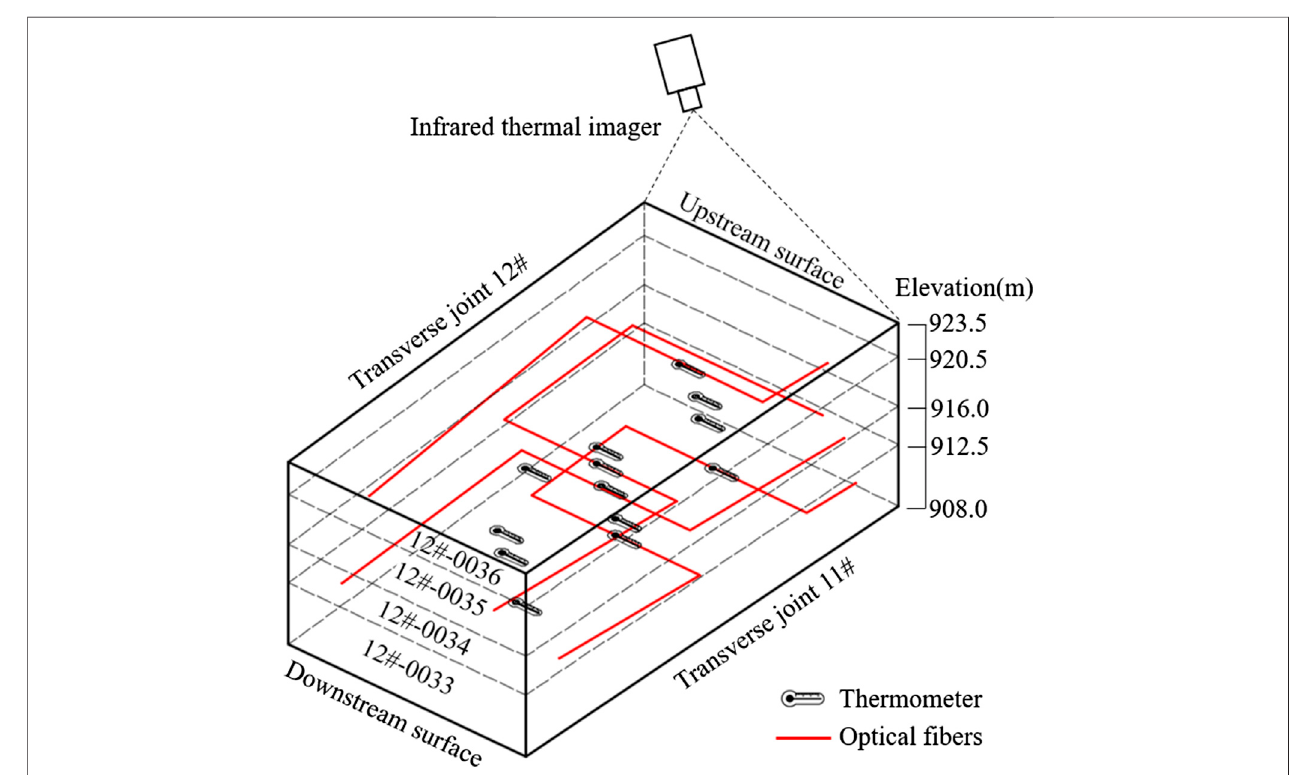
FIGURE 11 | The arrangement of thermometers, distributed optical fi bers and infrared thermal imagers in the concrete blocks 12#-0033, 0034, 0035, 0036.